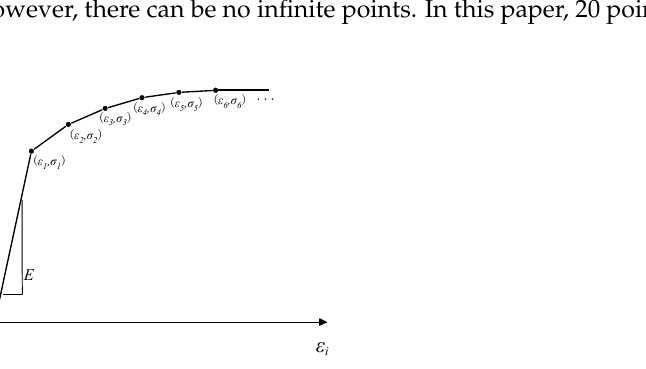
Figure 6. Multilinear isotropic hardening.